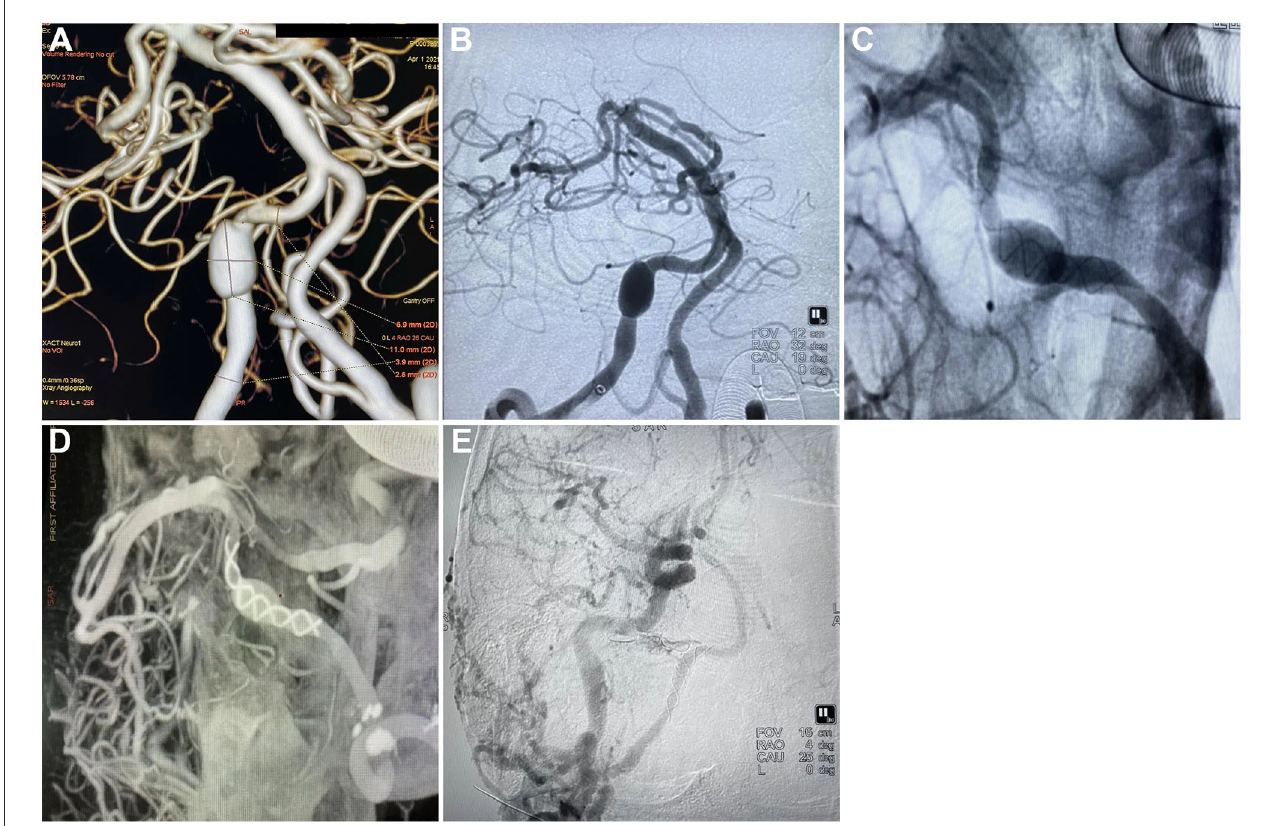
FIGURE1 Tubridge treatment on vertebral artery dissecting aneurysm and the follow-up. (A) CTA scan showing the dissecting aneurysm in the right vertebral artery, section 4 (V4); (B) DSA showing the dissecting aneurysm in the right vertebral artery, section 4 (V4); (C) Release of Tubridge flow diverter (3.5 × 55mm); (D) DSA showing a goof wall apposition after final deployment of the flow diverter; (E) Follow-up 6 month after the treatment found no silhouette of the dissecting